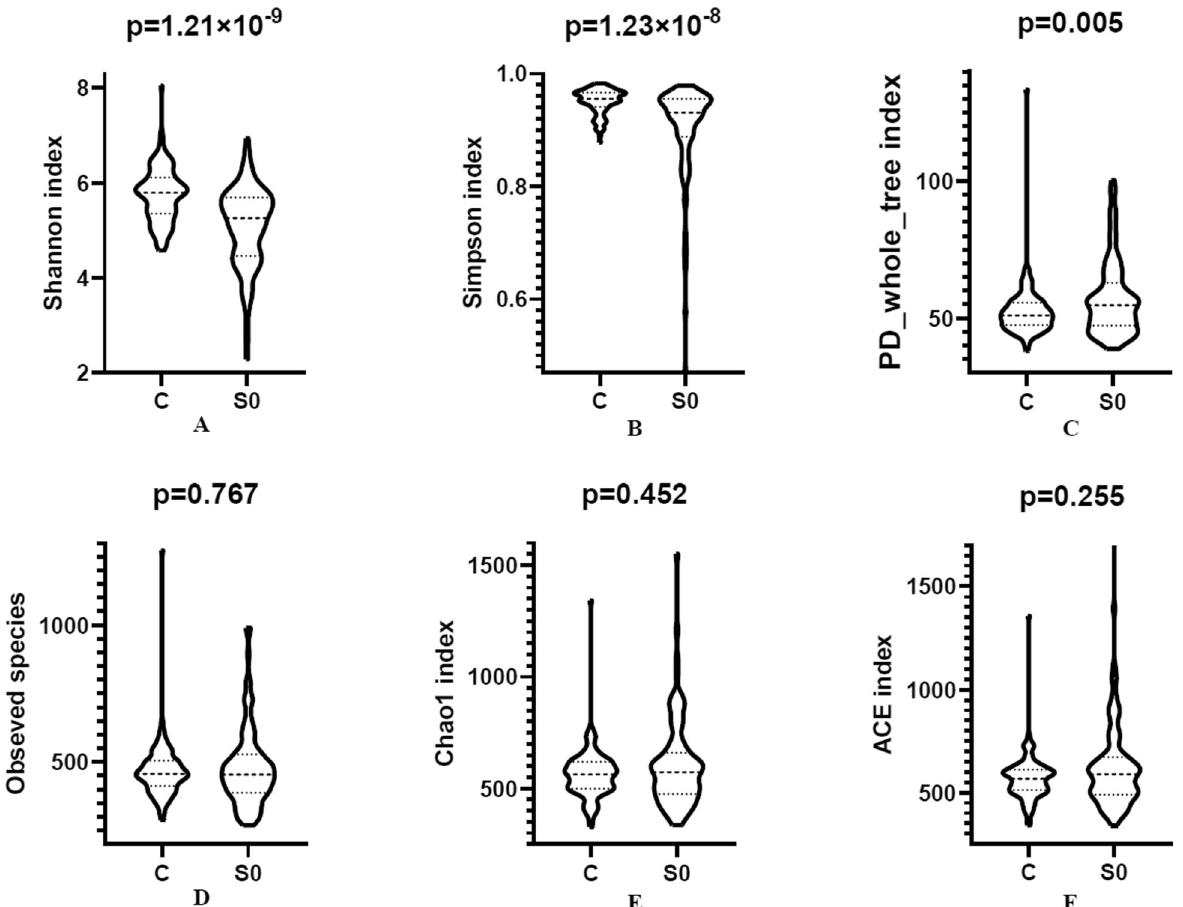
Fig. 2 The alteration of α diversity in SCH patients. S0: schizophrenia, C: healthy controls. FDR were used to correct the multiple